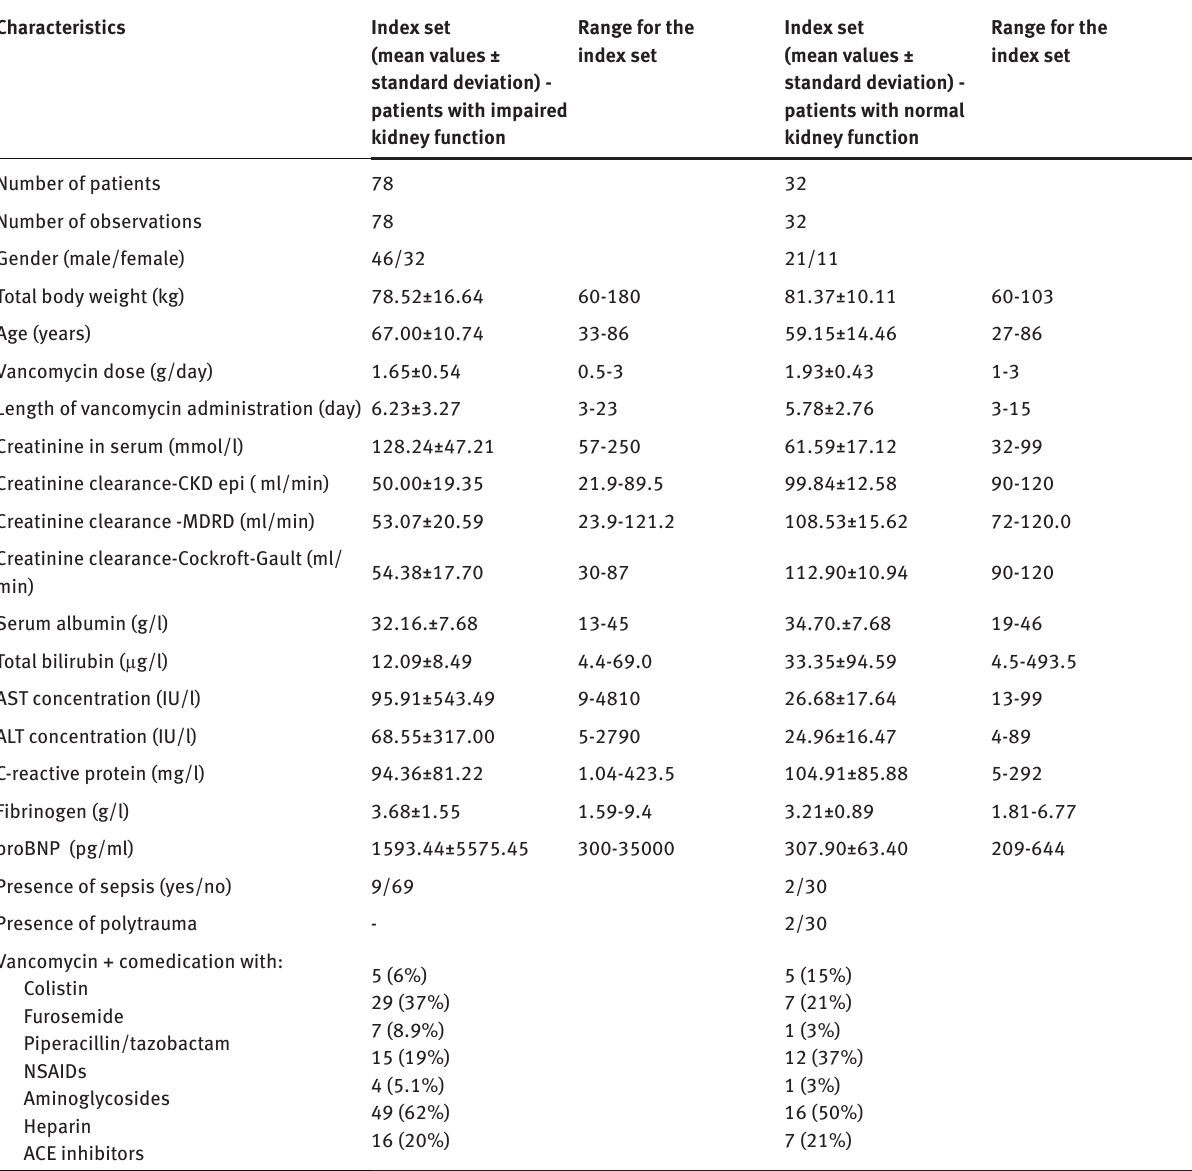
Table 1: Baseline demographic, laboratory and clinical data from the study groups.